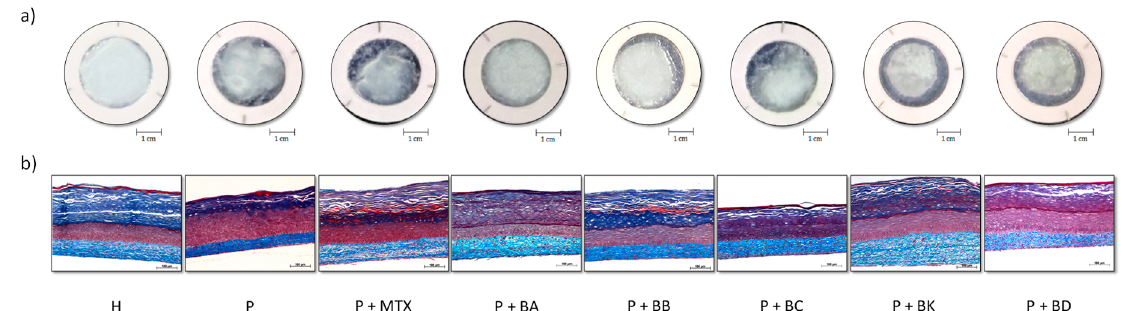
Figure 2. Macroscopic ( a ) and histological ( b ) analyses of tissue-engineered skin substitutes. Photos are of healthy (H) and psoriatic (P) substitutes and psoriatic substitutes treated with methotrexate (MTX), balsacone A (BA), balsacone B (BB), balsacone C (BC), (±)-balsacone K (BK) or (±)-iryantherin-D (BD).